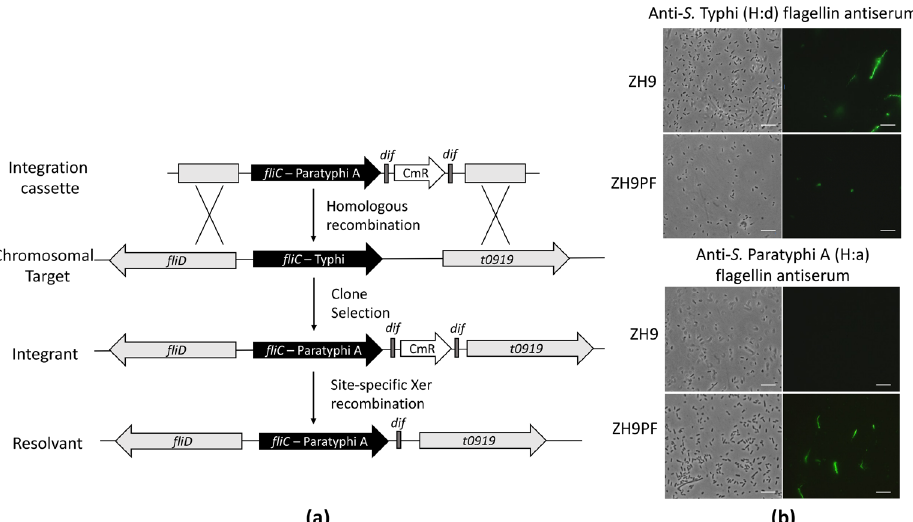
Figure 1. Replacing the S. Typhi (H:d) flagellin with S. Paratyphi A (H:a) flagellin. ( a ) The genetic engineering process to generate S. Typhi ZH9 expressing S. Paratyphi A flagellin (ZH9PF). Adapted with permission from Bloor and Cranenburgh, 2006 [23]. ( b ) Fluorescence microscopy with S. Typhi ZH9 and the derivative strain, ZH9PF, probed with H:d antiserum (anti- S. Typhi) or H:a antiserum (anti- S. Paratyphi A) plus Dylight 488 secondary antibodies; the left column images are phase contrast images, and the right column images are immuno-fluorescence images. Images were taken at 100 × magnification. Scale bars represent 10 µ m. Representative images were based on three independent experimental